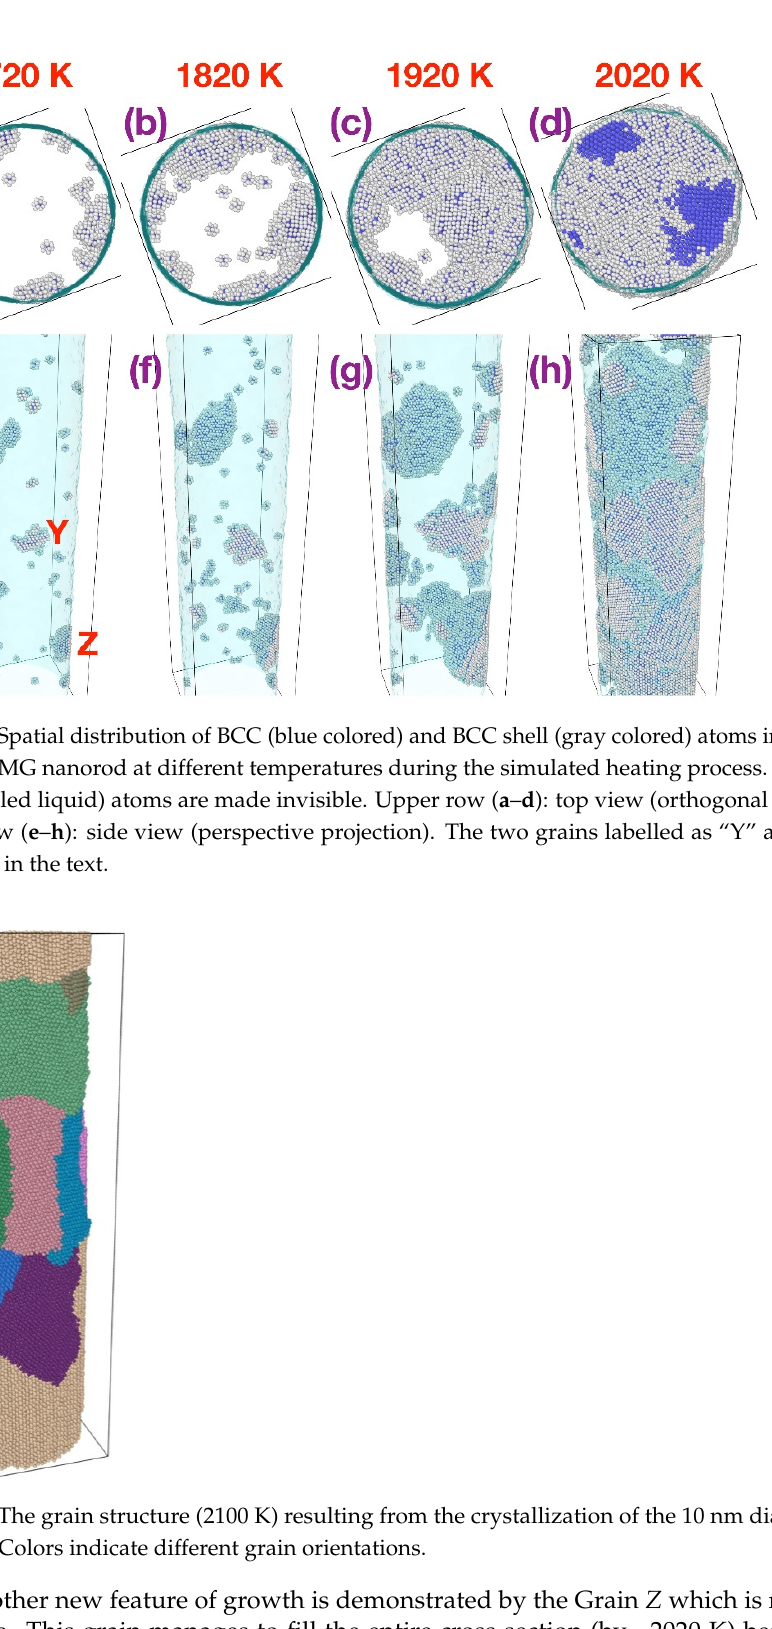
Figure 8. Number of supercritical nuclei (grains) as a function of time (and temperature) for the nanorods of different diameters (the drop past the peaks is due to coarsening/merging of the grains with continuously increasing temperature). Finally, we point out that the above reported results should be largely valid over a range of nanorod diameters. In the meantime, it can also be inferred that, when the nano- rod diameter increases beyond a certain value (possibly a few hundred nanometers), ho- mogeneous nucleation of crystals from the interior of the supercooled liquid may start to take a role before the supercritical nuclei formed on the free surface could transform the entire sample to a crystalline structure. MD simulation of the crystallization of the bigger diameter nanorods, however, would be much more computationally expensive. 4. Conclusions We have performed molecular dynamics simulations of crystallization in metallic glass nanorods with varied diameters, and post-simulation atomistic visualization and